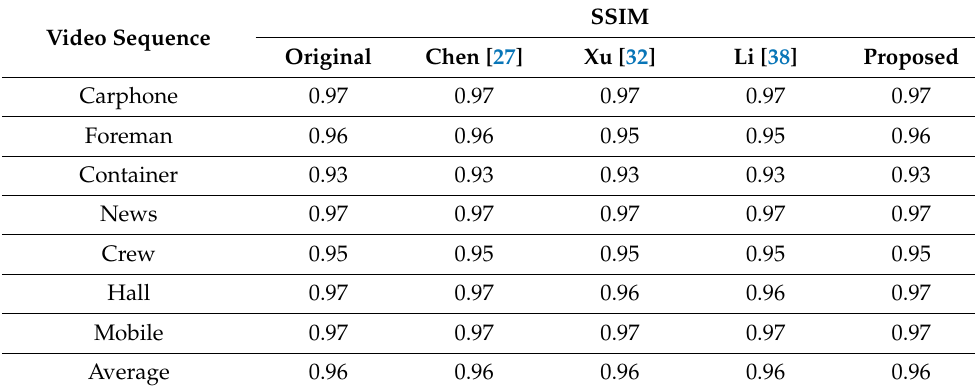
Table 2. Comparison of SSIM values of seven video sequences with other